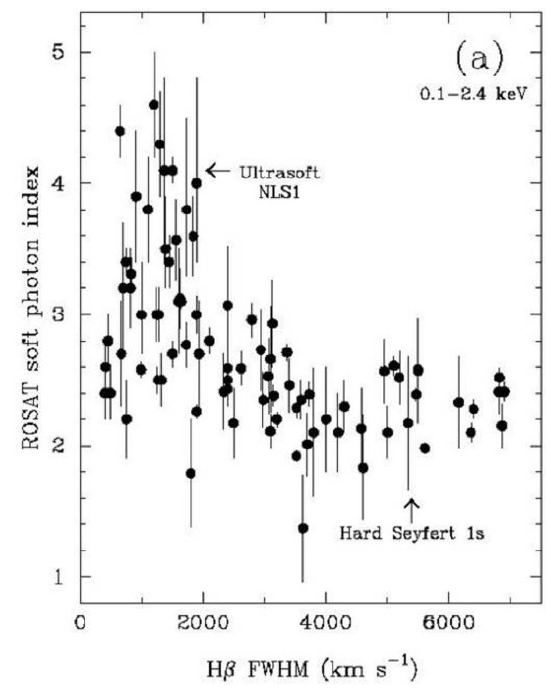
Figure 1: FWHM value of the H β line versus the ROSAT photon index for broad line Seyfert 1 galaxies and Narrow-line Seyfert 1 Galaxies. Below 2000 km s − 1 the photon index reach values up to about